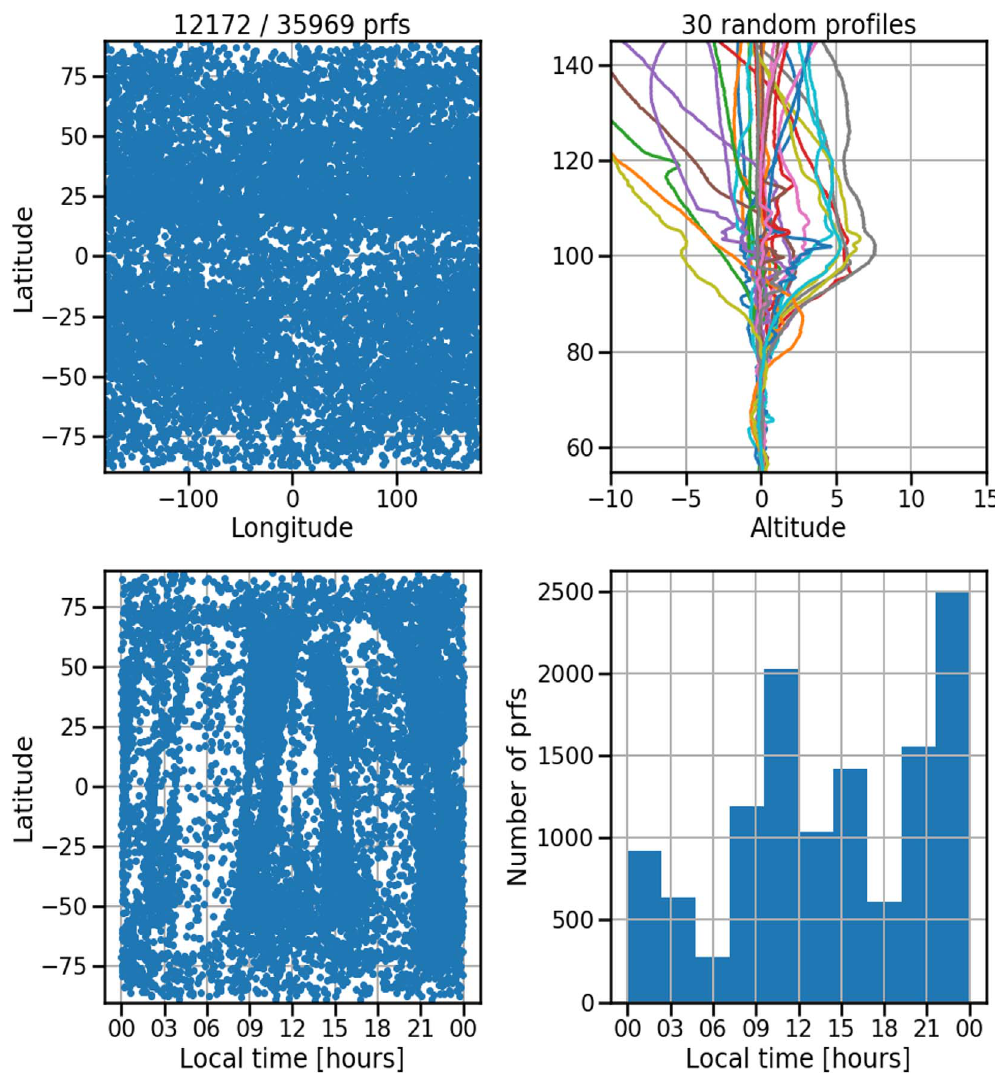
Fig. 3. Dataset of 12,172 perturbed sTEC pro fi les. Upper left: location of all the sTEC pro fi les in latitude vs. longitude. Lower left: location of all the sTEC pro fi les in latitude vs. local time. Upper right: 30 randomly selected pro fi les. Lower right: local time histograms of sTEC pro fi les.